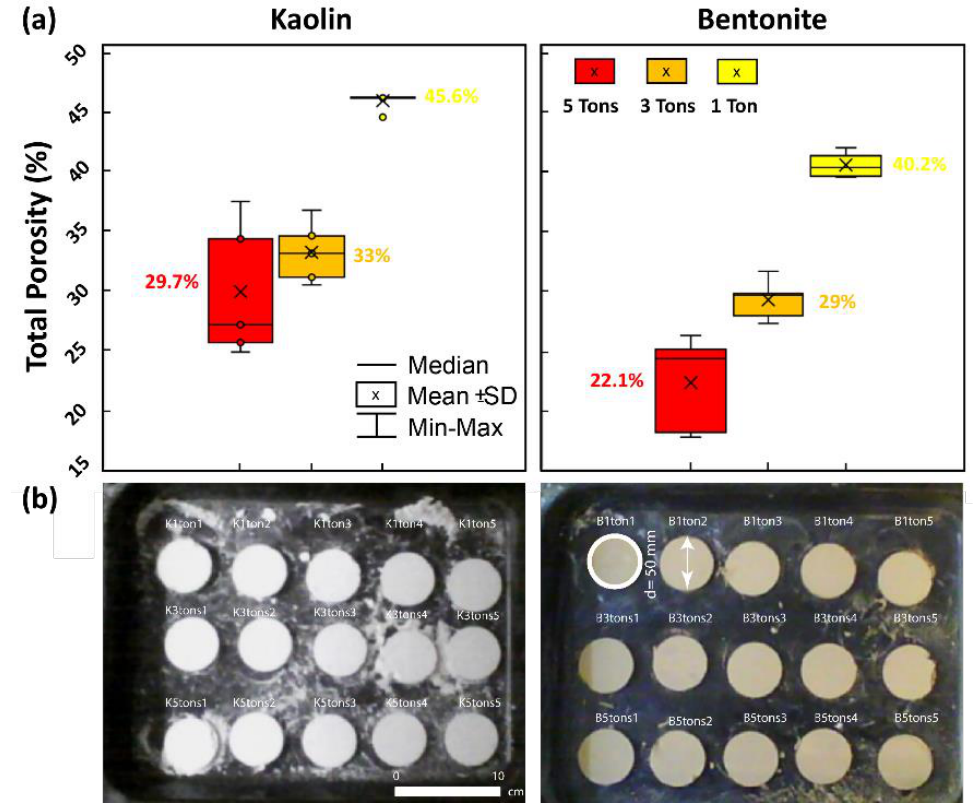
Figure 1. ( a ) Box plot of porosity distribution for kaolin ( left ) and bentonite ( right ) samples after compaction; ( b ) photographs showing the samples placed on a tray, ready for oven-heating.